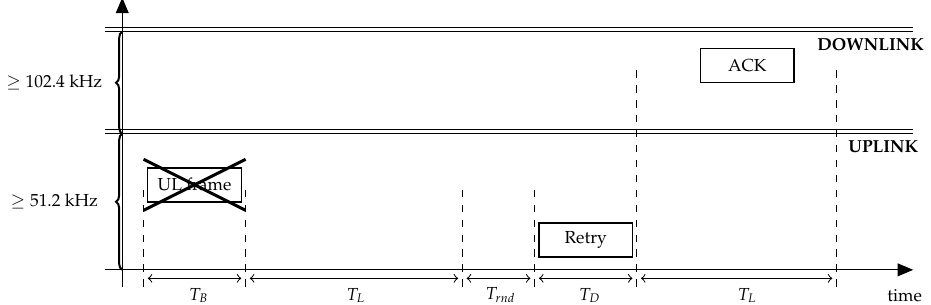
Figure 7. DRX transmission procedure in NB-Fi (here, the first transmission attempt is unsuccessful).